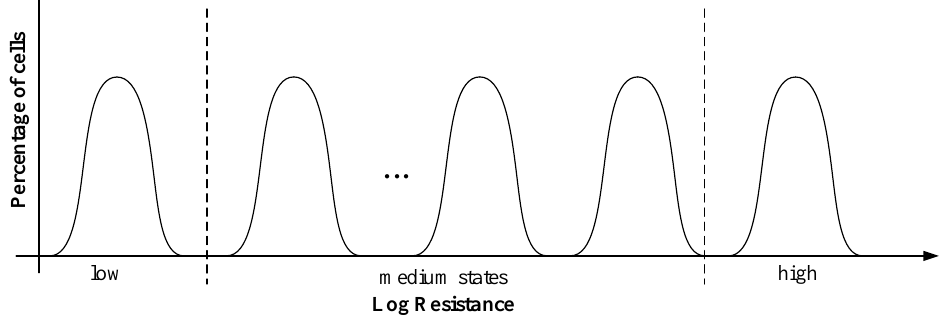
Figure 3. Resistance distribution of multilevel storage in phase change memory. Due to the characteristics of phase change materials, the resistance of PCM cell will change with time, resulting in resistance drift [18]. In the multilevel storage of PCM, the resistance values of intermediate states overlap with those of other adjacent resistance states, which leads to readout errors. Figure 4a shows the resistance distribution of 2-bit storage on PCM. From the Figure 4b, the curves are drifting by the decrease in the resistance.